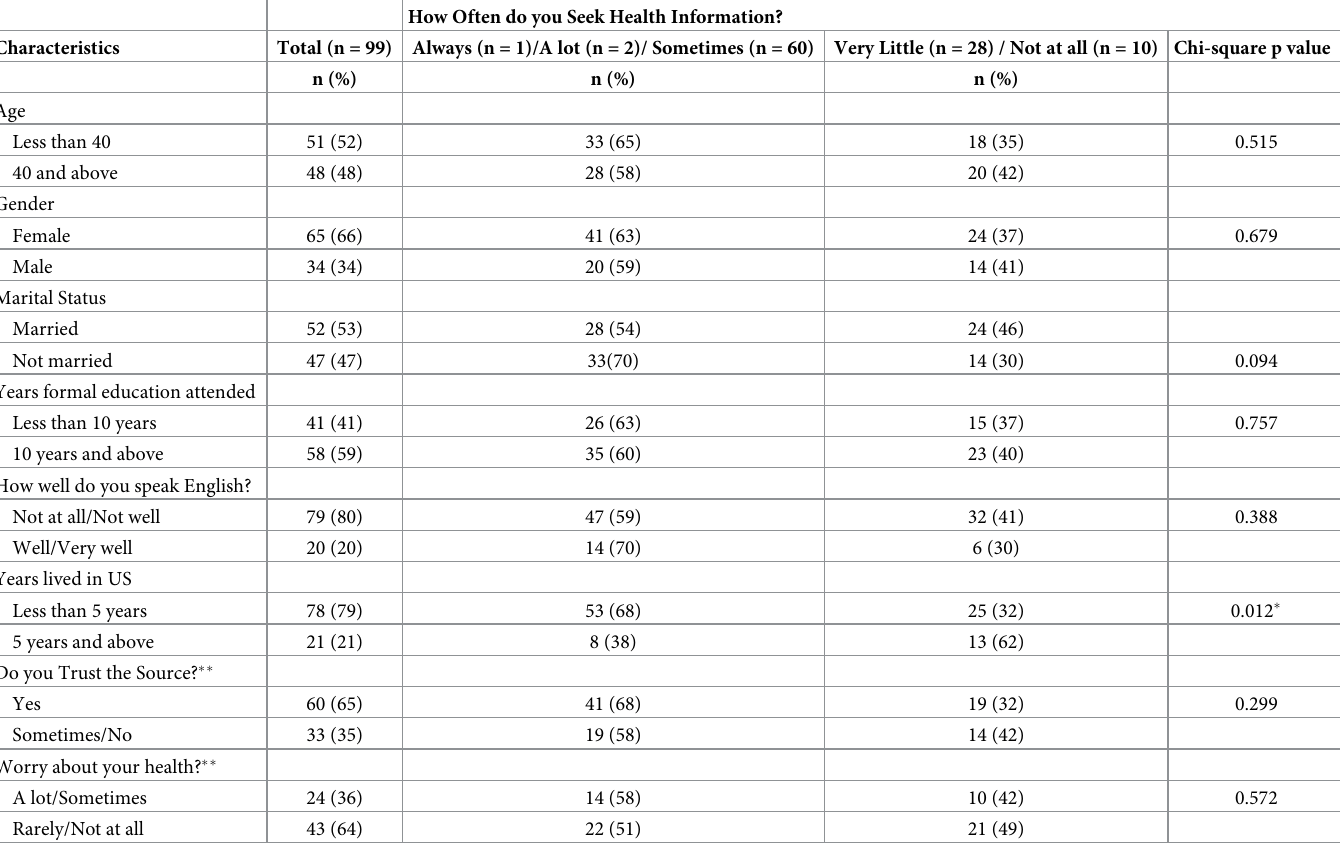
Table 4. Frequency of seeking health information, by sociodemographic characteristics of Congolese building bridges participants, January 2018 –March 2020 (n = 99). How Often do you Seek Health